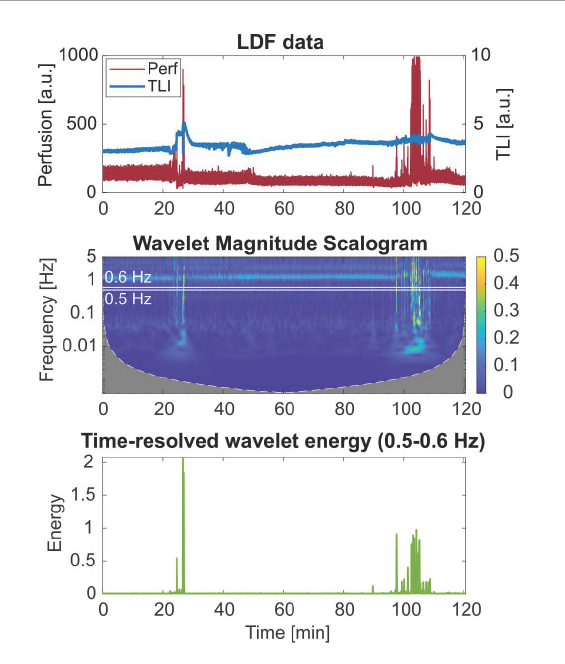
FIGURE4 Comparison of the frequency content based on Fourier transform (PSD) and Wavelet transform (| wt| 2 ). (A) Stable laser Doppler flowmetry (LDF) data. (B) Data containing movement artifacts. Frequency components for vasomotion and heart rate (HR) are marked in panels (C,E) from the stable data, which cannot be distinguished in panels (D,F) belonging to the artifact region.